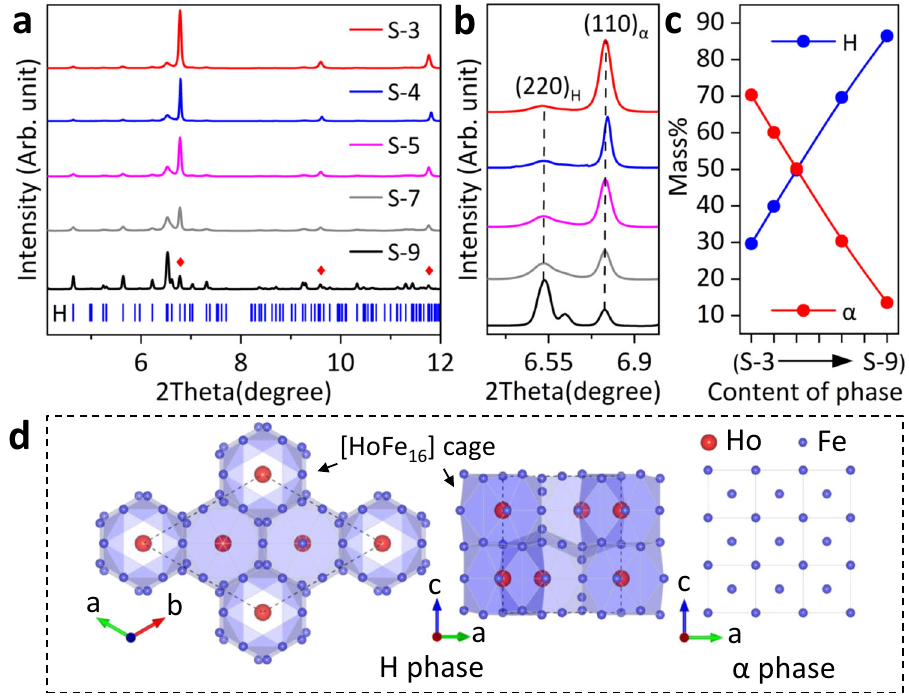
Fig. 1 Phase and crystal structures. a , b High-resolution synchrotron X-ray diffraction pro fi les for S-3 to S-9 ( λ = 0.23991 Å), the marked red diamond is the α phase. c The mass fractions of H and α in S-3 to S-9 are determined via Rietveld re fi nements. d Crystal structures of H and α phase, respectively.